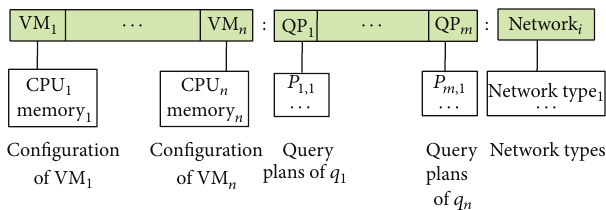
Figure 5: Chromosome structure for the proposed multiobjective genetic algorithm that consists of the virtual machines, the query plans, and the network